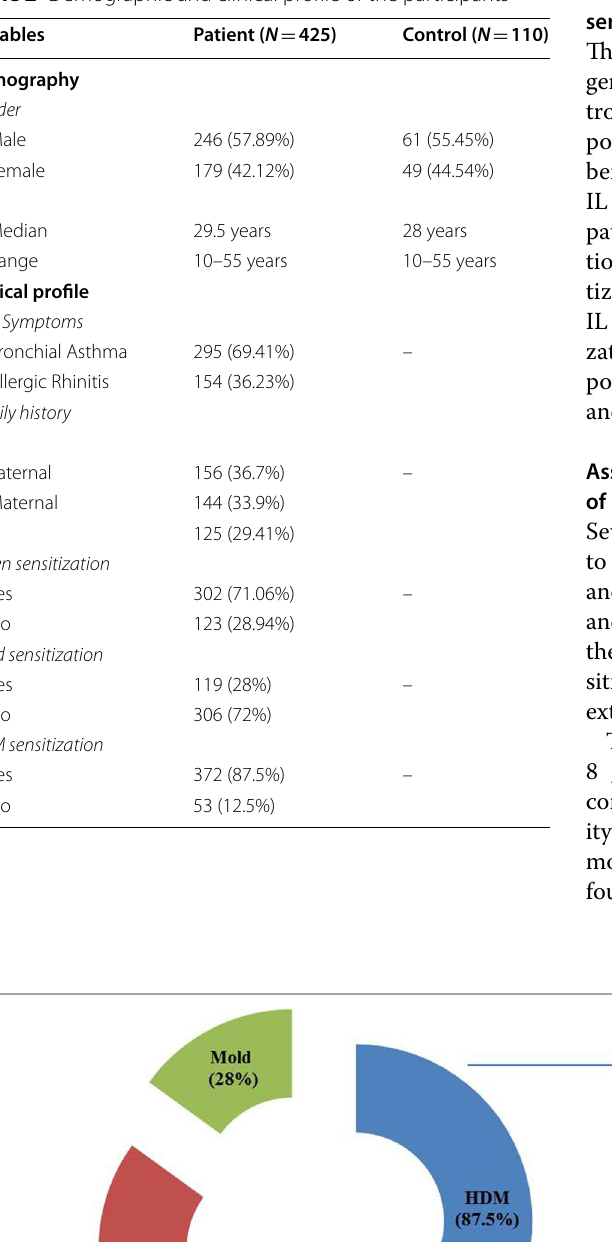
Table 2 Demographic and clinical profile of the participants